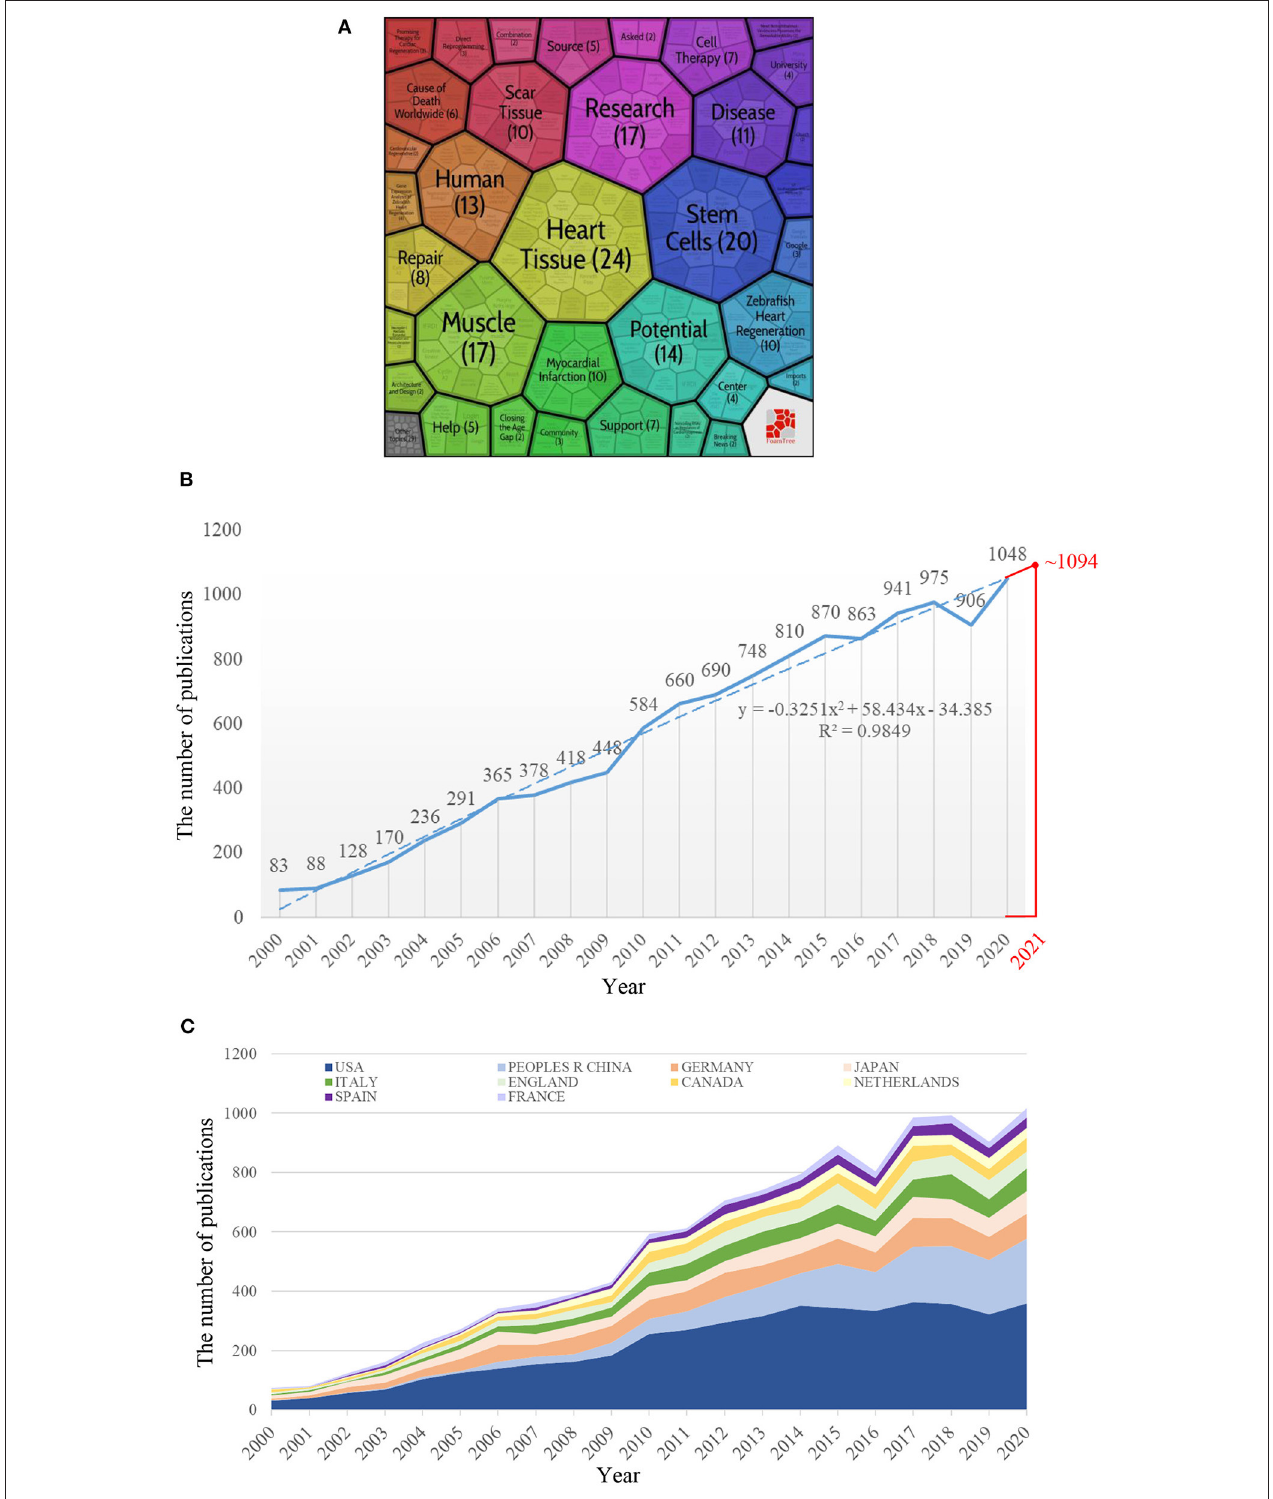
FIGURE 1 | The annual number of publications worldwide or top 10 productive countries/regions. (A) The first 100 publications of a web search. (B) The annual number of publications worldwide from 2000 to 2020. The fitting formula was y = − 0.3251x 2 + 58.434x – 34.385. (C) The annual number of publications of the top 10 productive countries/regions from 2000 to 2020. Among the 10 countries, the People’s Republic of China has seen the fastest growth in the number of publications in recent years.